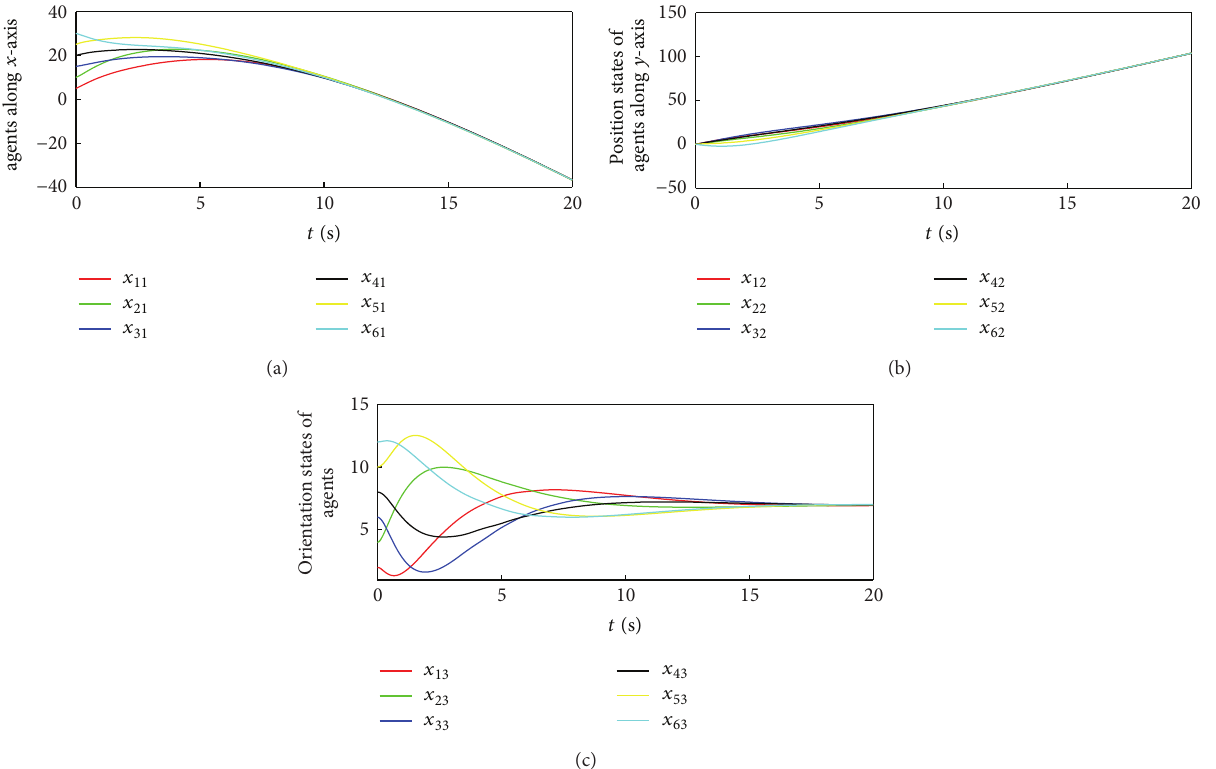
Figure 5: The evolution of states of the CMVWT